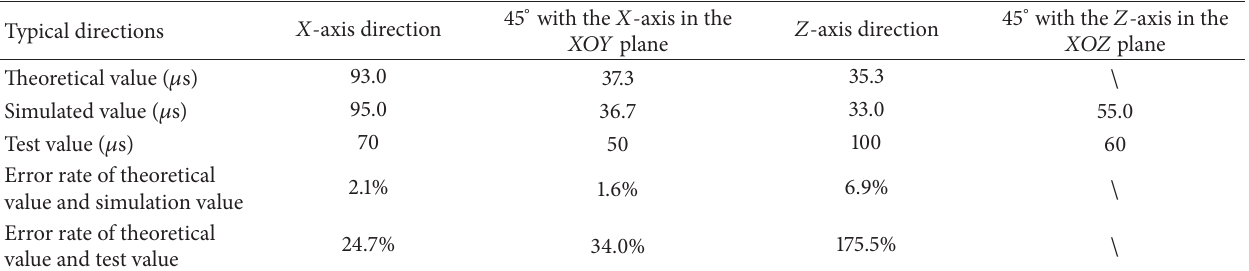
Table 1: Theoretical value, simulation value, and test value of contact time in typical